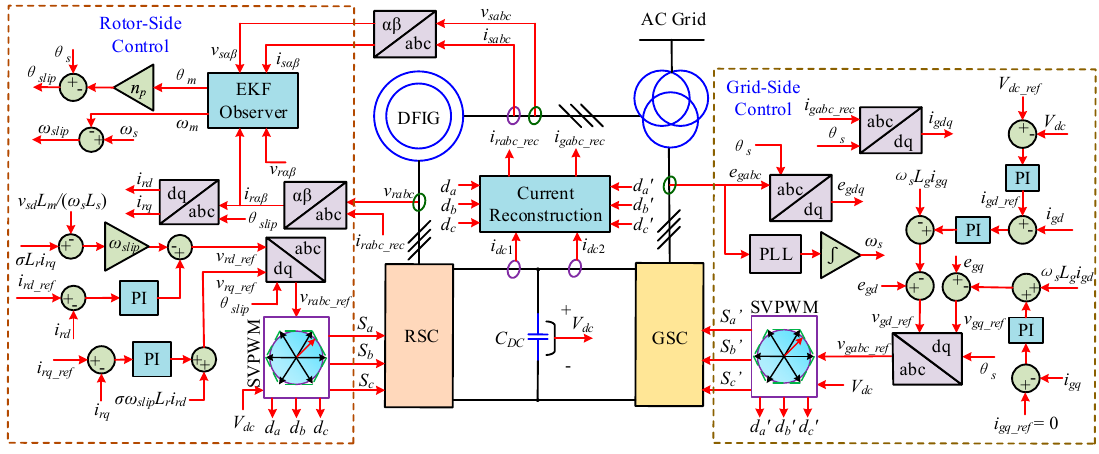
Figure 12. Hybrid sensorless control strategy for the severe sensor failure scenario in DFIG-WT.